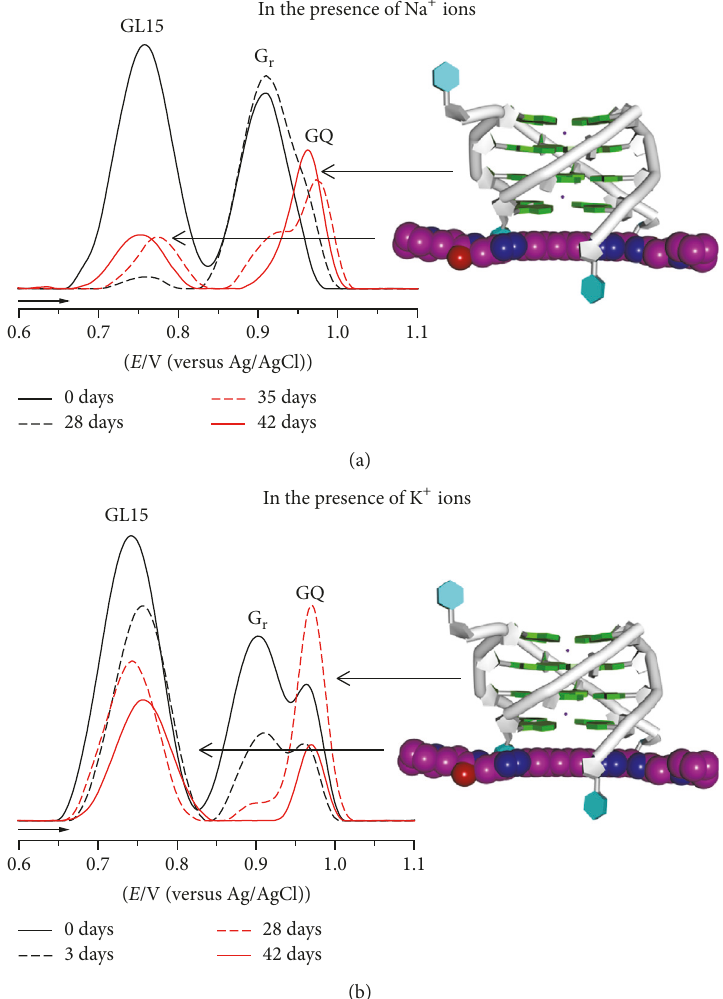
Figure 5: DP voltammograms baseline corrected in 3.0 𝜇 M d(TG 4 T) incubated with 4.0 𝜇 M GL15 in pH 7.0, at different incubation times, in the presence: (a) Na + and (b) K + ions. [Adapted from [53] with